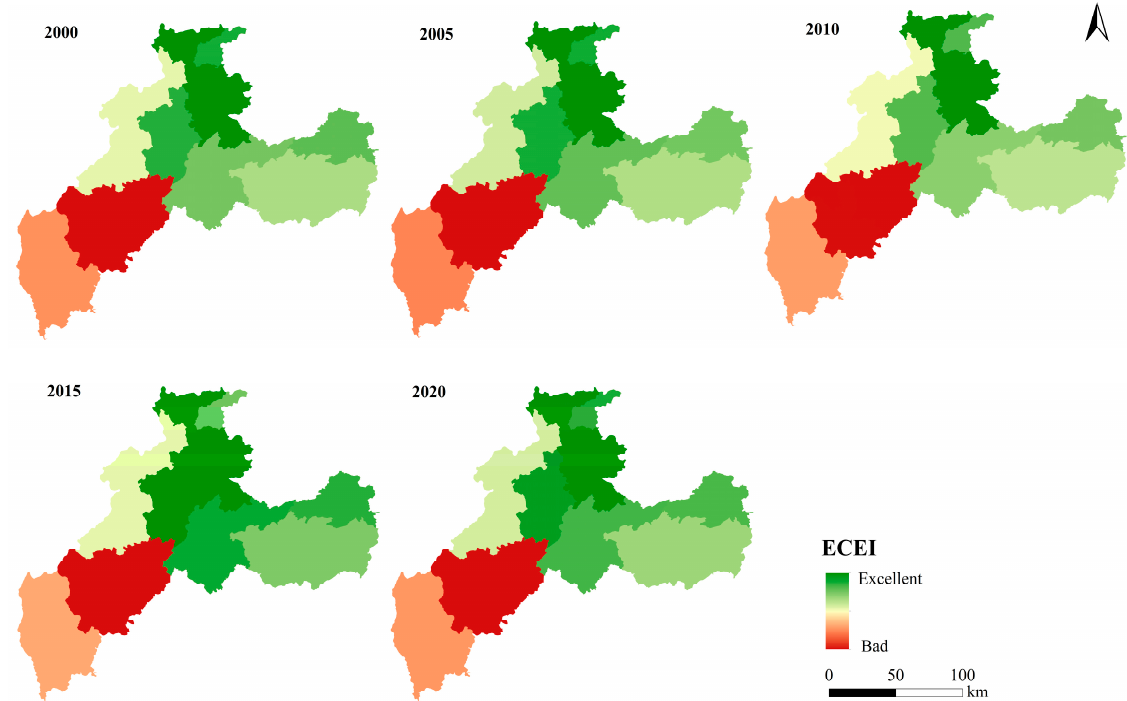
Figure 5. Spatial distribution of ECEI in Zhaotong from 2000 to 2020 at the county